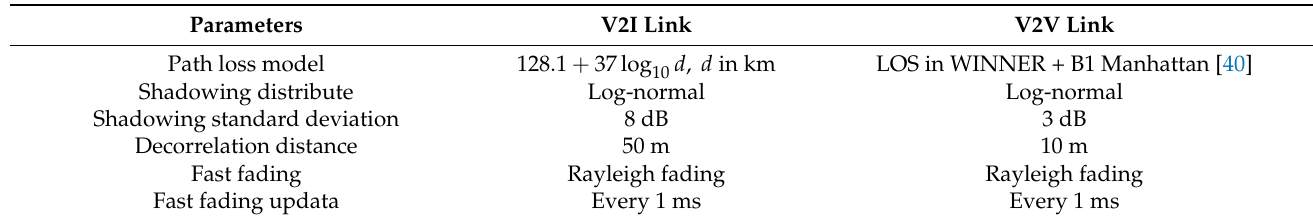
Table 3. The channel models for the V2V link and V2I